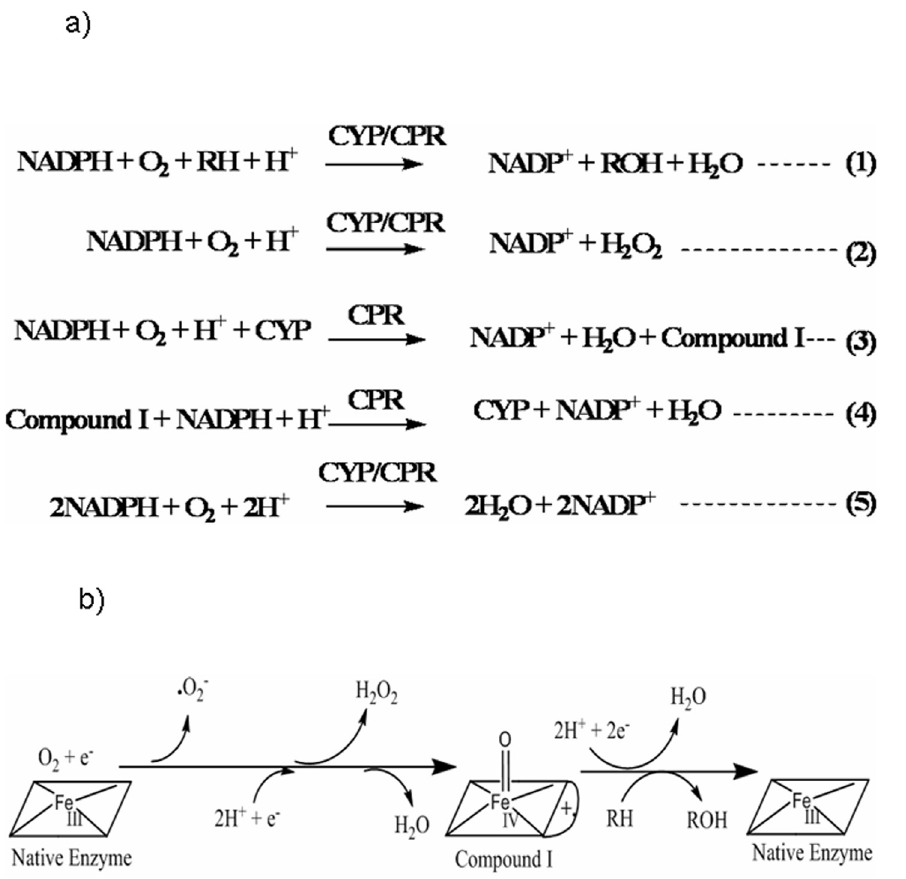
Figure 1. Hitherto held impressions of heme-centered phenomena in CYP + CPR reaction mixtures. 1a:Thereactionsinvolvedin CYP + CPRmixtures . 1b:ErstwhilemechanismforDROSandwaterformationathemecenter: The reactions above the straight arrows are uncoupled where as the ones below is the coupled/‘normal’ course.